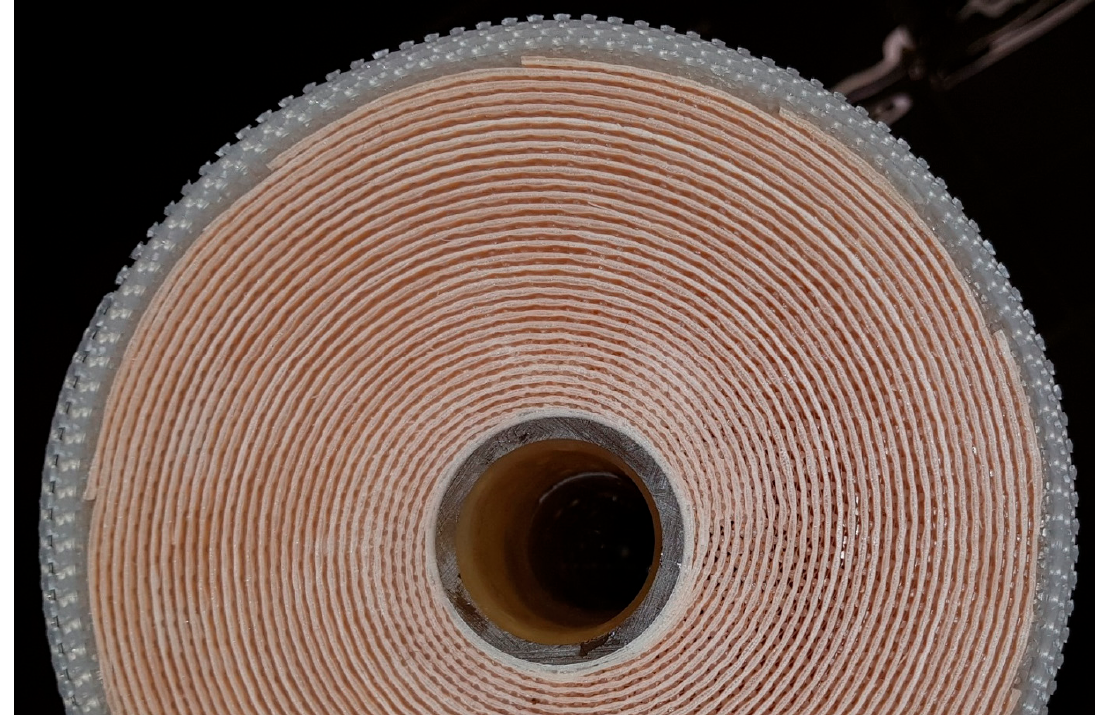
Figure 13. Front face of the SWM with the parallel spacer.